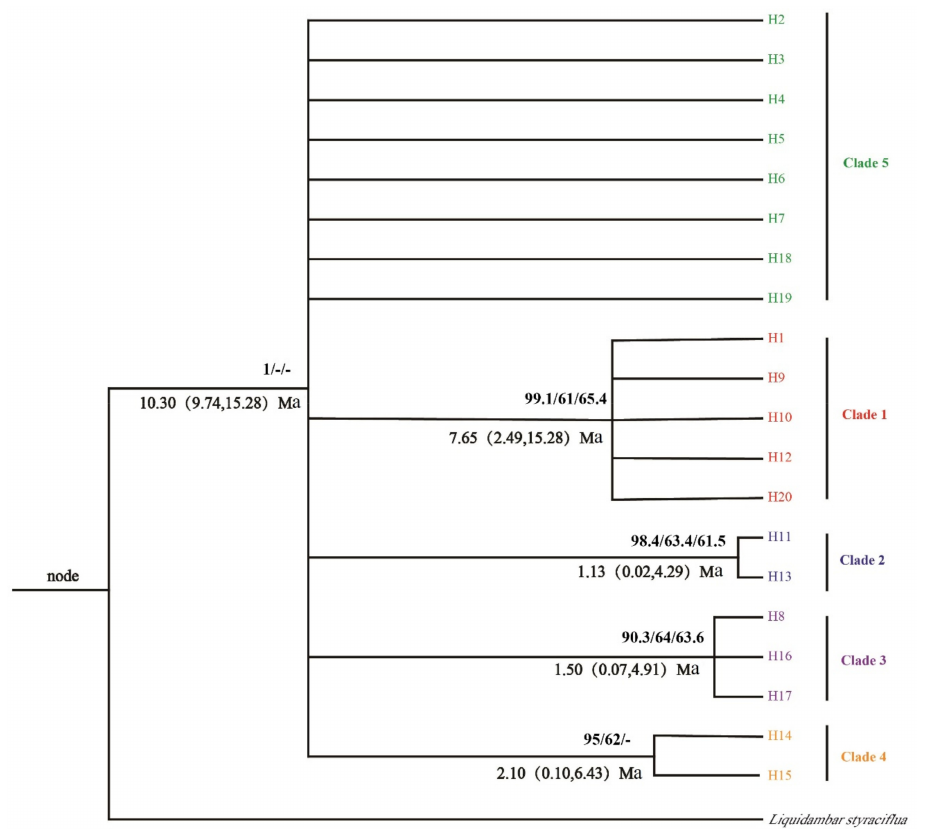
Figure 4. Phylogenetic tree of L. formosana based on 20 haplotypes result from combined analysis of four cpDNA sequence data, the values on the branches are the posterior probability ( > 0.9) and bootstrap support values ( > 50%) for the maximum-likelihood (ML) and maximum-parsimony (MP) analyses; divergence time and 95% HPD are given (in millions of years) under the